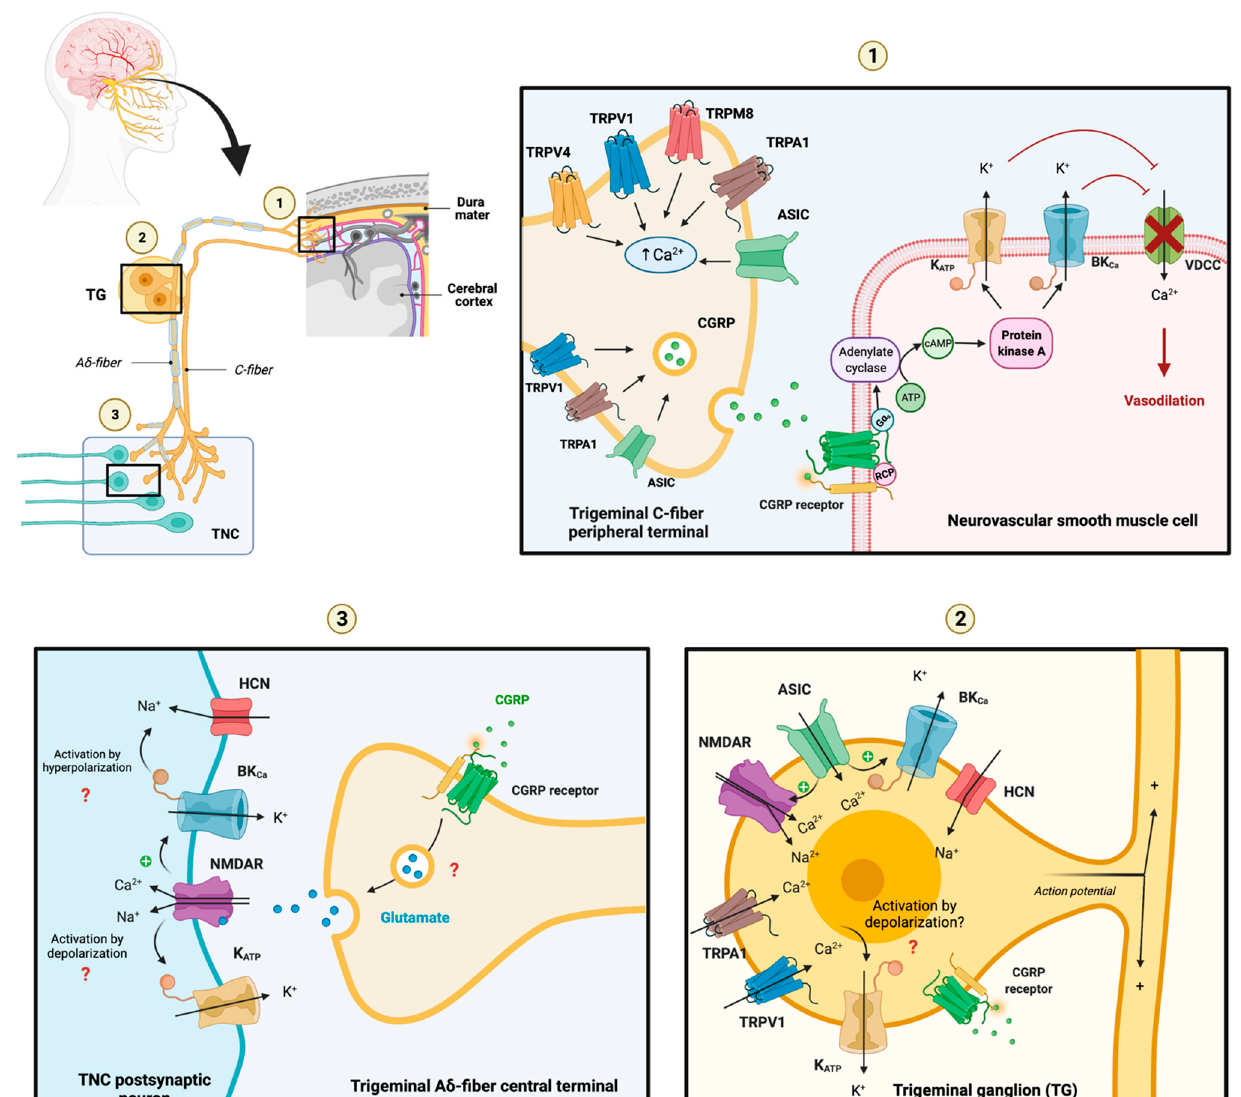
Figure 7. Molecular interplay between ion channels in trigeminovascular system. ( 1 ) Peripheral terminal of trigeminal C-fibre and neurovascular smooth muscle cell. ( 2 ) The trigeminal ganglion (TG). ( 3 ) Central terminal of trigeminal A δ -fiber and neuron within the trigeminal nucleus caudalis (TNC). Nociceptive signals from the meninges and other cranial tissues including blood vessels reach multiple cortical areas through the trigeminal pain pathway consisting of peripheral trigeminovascular neurons in the TG, central trigeminovascular neurons in the TNC, and thalamic neurons (not shown). The dural and pial blood vessels are innervated by sensory and autonomic nerves that express vasoactive neuropeptides including CGRP (the most abundant in sensory neurons co-expressed with PACAP), substance P, and VIP (primarily found in autonomic neurons). Knowledge about the response properties of leptomeningeal sensory and autonomic nerves and their activation during migraine headache is limited. It is believed that local sterile meningeal inflammation mediates the prolonged activation and sensitization of meningeal nerves leading to migraine headache. However, the origin of such neurogenic inflammation remains elusive. Upon inflammation, action potentials from activated sensory fibres are conducted antidromically and invade peripheral end branches resulting in the